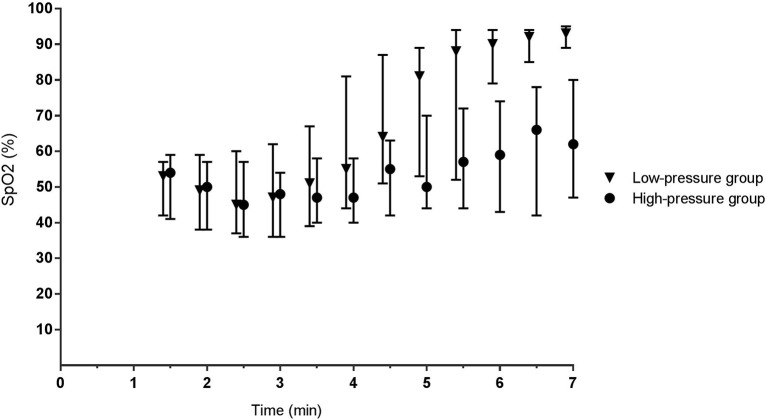
Oxygen saturation. Data is presented as median (IQR). For the high-pressure group, at 1.5 and 2 min, the mean of the high-pressure group is calculated based on n = 9 and n = 16, respectively. All other presented data is based on n ≥ 20.